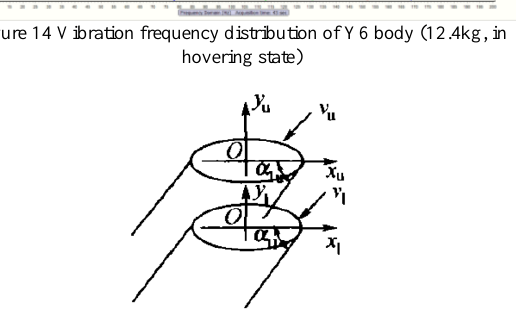
Figure 15 Diagram of the downwash of coaxial rotors in forward flying(reference